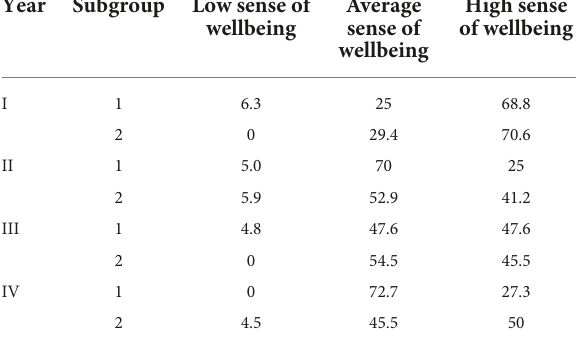
TABLE 6 Frequency of occurrence of different levels of wellbeing in psychology students before classes (in %). Year